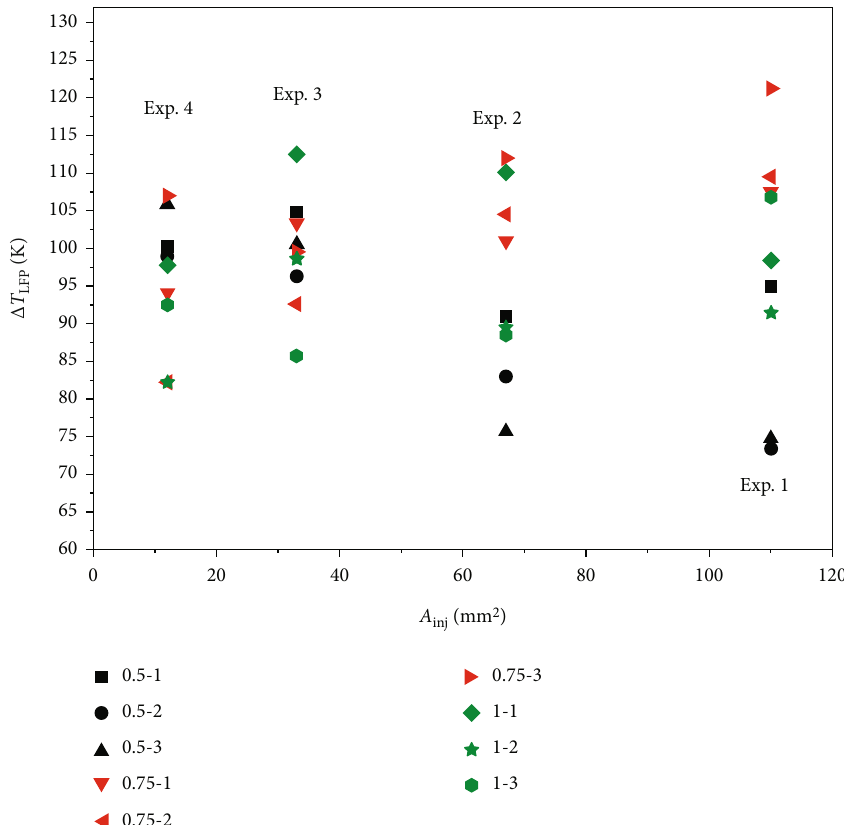
Figure 10: Experimental Δ T